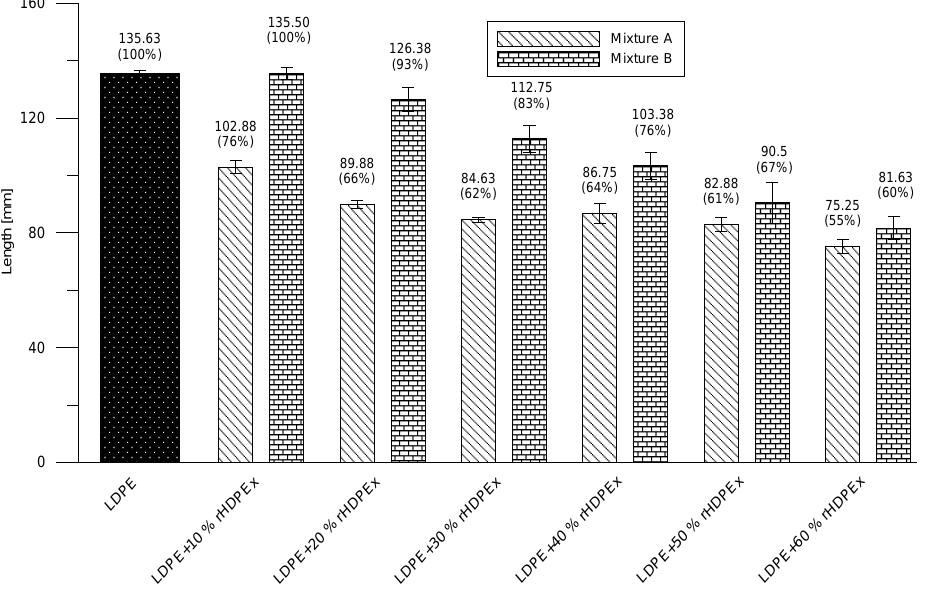
Figure 15. Polymer fluidity comparison—Mixtures A and B.